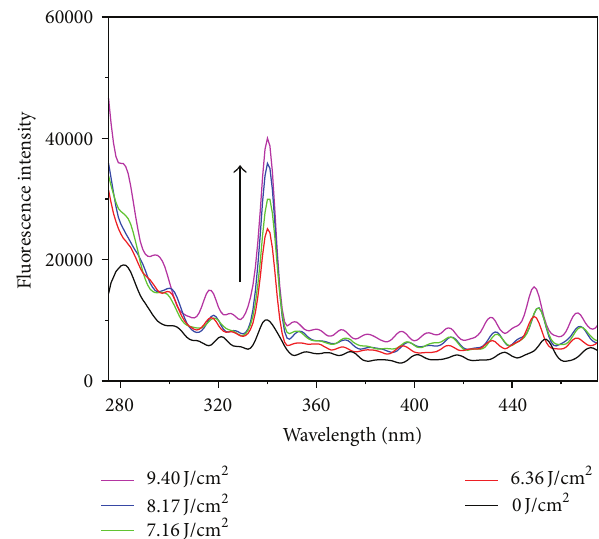
Figure5:Fluorescenceemissionspectraoffusedsilicapreirradiated in vacuum with 100 pulses at different laser pulse energies (0J/cm 2 , 6.36 J/cm 2 , 7.16 J/cm 2 , 8.17J/cm 2 , and 9.40 J/cm 2 ); 𝜆